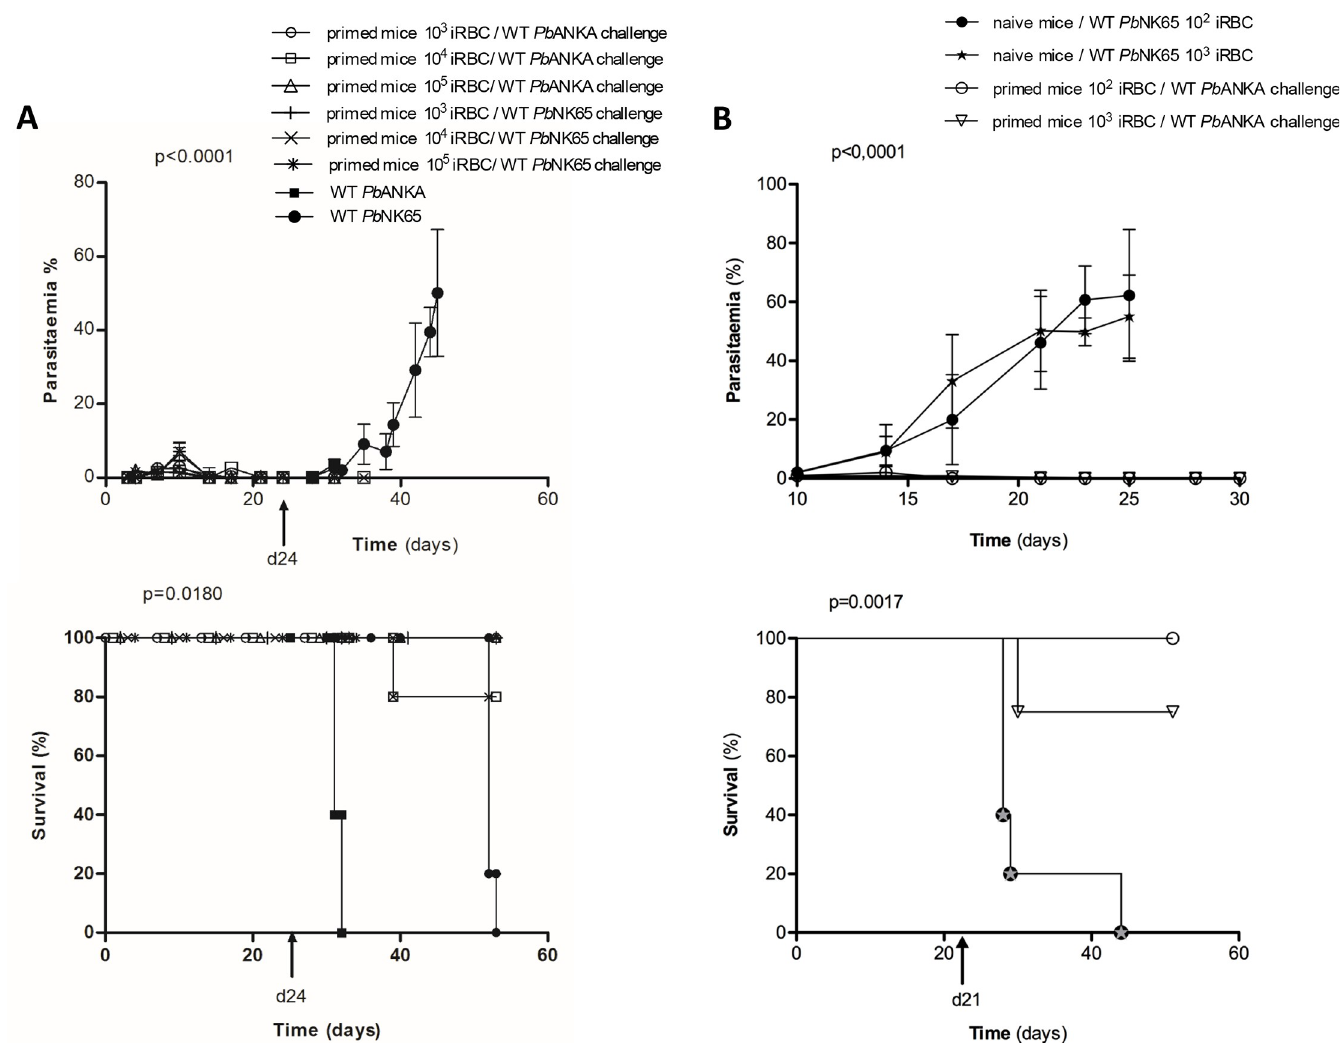
Fig 3. Dose response experiment to evaluate the number of Δ hmgb2 Pb NK65 RBC capable to trigger protection against the lethal wild type parasites. Three sets of mice (n = 5) were primed with different concentration of Δ hmgb2 Pb NK65: iRBC (10 5 , 10 4 and 10 3 ). At d24 post priming the three sets of mice were subsequently challenged with the two highly pathogenic parasites either 10 5 WT Pb NK65 or WT Pb ANKA. A. Parasitaemia was monitored as in Fig 1. B. Survival was monitored as depicted in previous figures. The symbols are summarized in the right part of the figure.